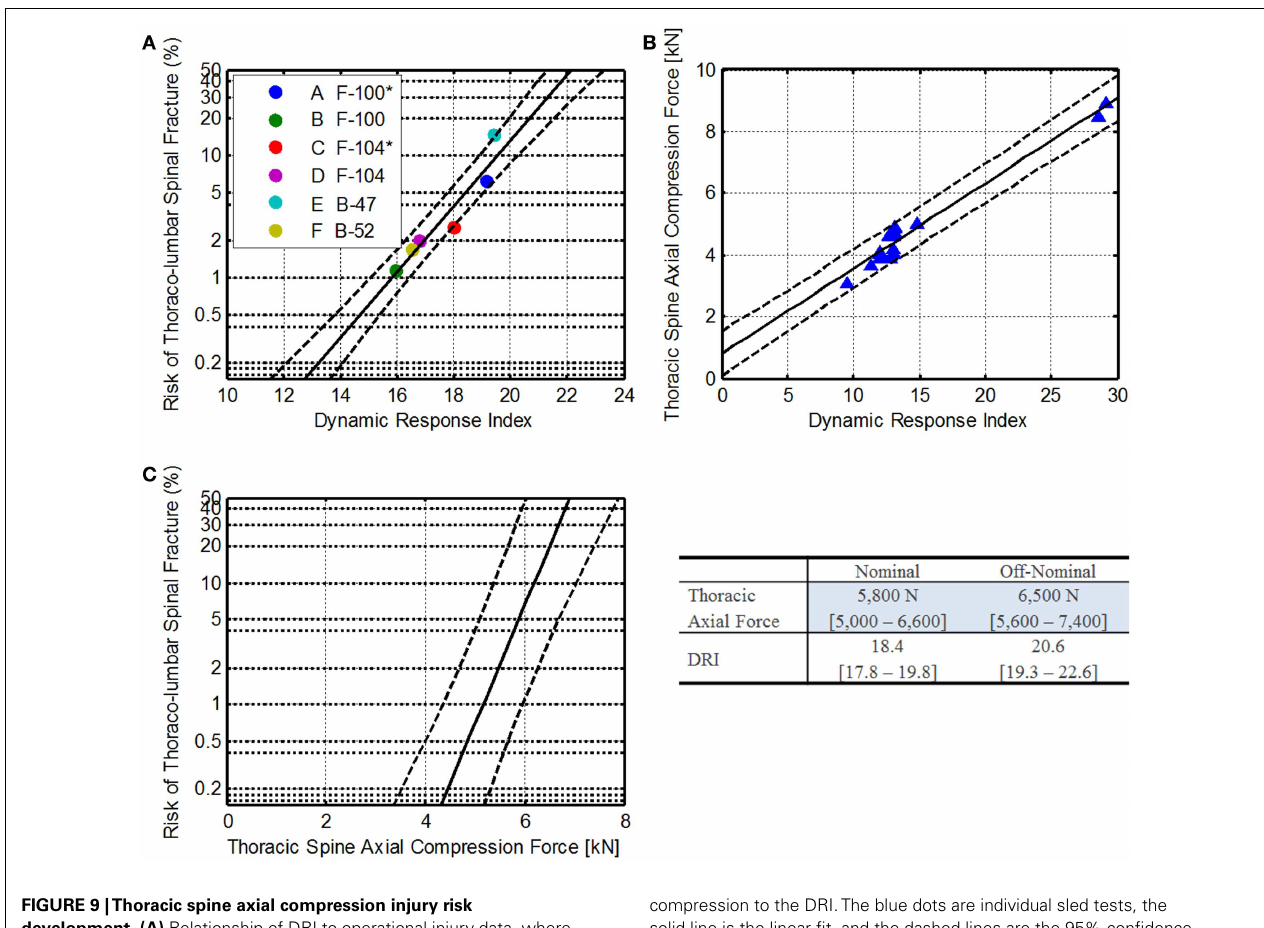
FIGURE 9 |Thoracic spine axial compression injury risk development . (A) Relationship of DRI to operational injury data, where * denotes rocket assisted ejections (Brinkley, 1968; Brinkley and Schaffer, 1971). (B) Comparison ofTHOR thoracic spine axial